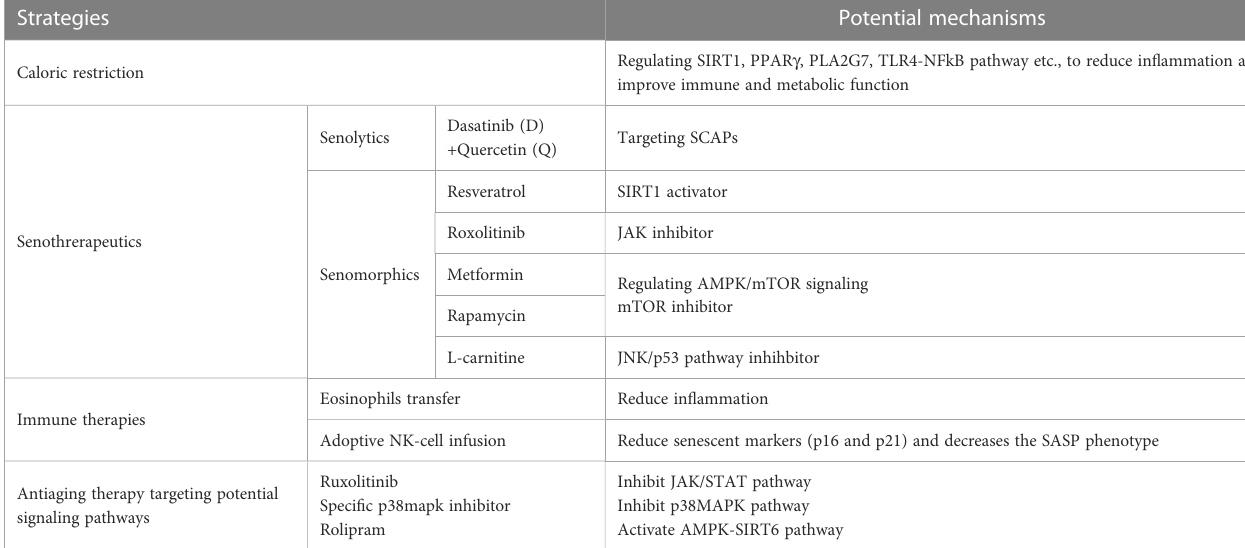
TABLE 3 Current antiaging strategies and their potential mechanisms.